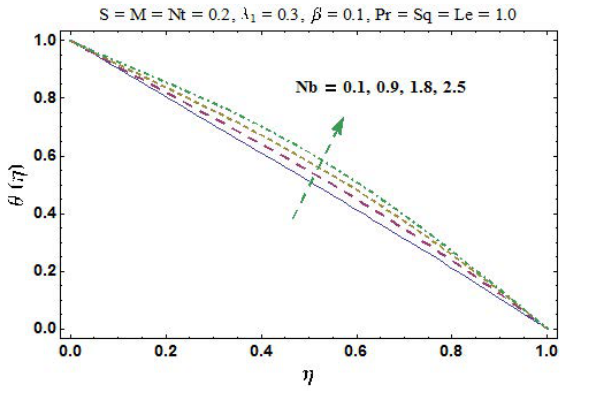
Figure 4. Plots of θ ( η ) for Nb .